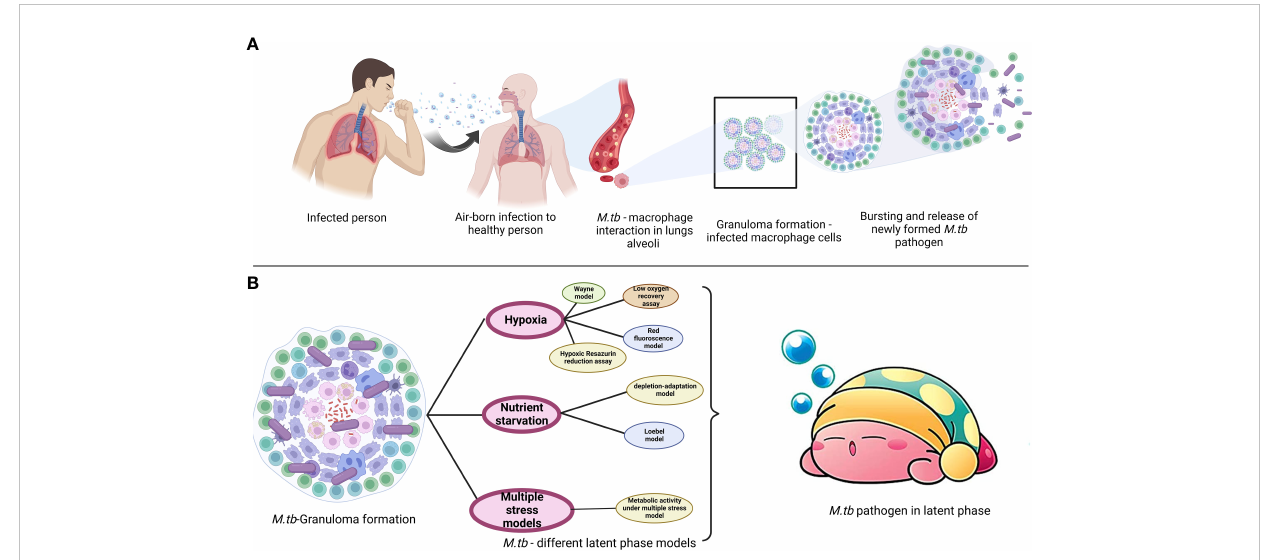
FIGURE 1 (A) Overview of M. tb. pathogenesis and (B) modes of development of resistivity